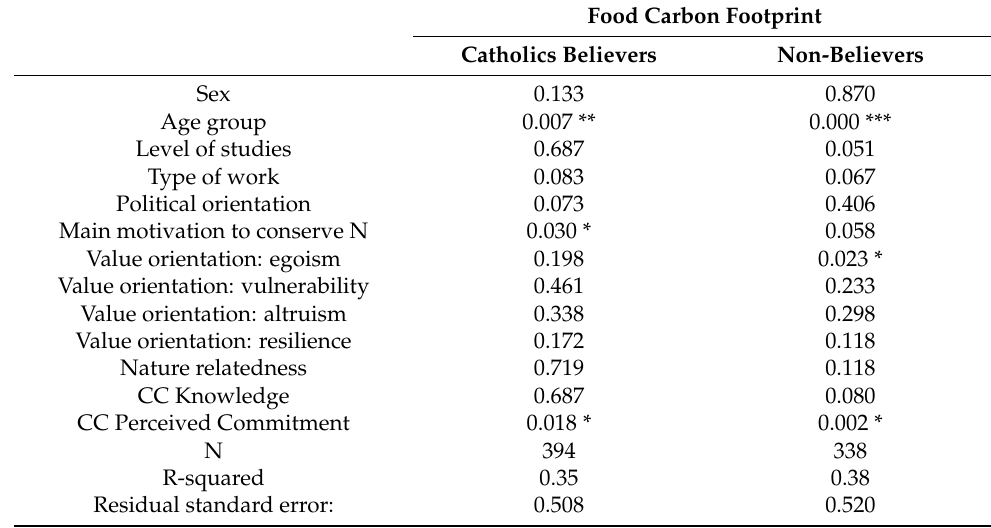
Table 7. Non-parametric regression model with internal and external factors for Food CF.